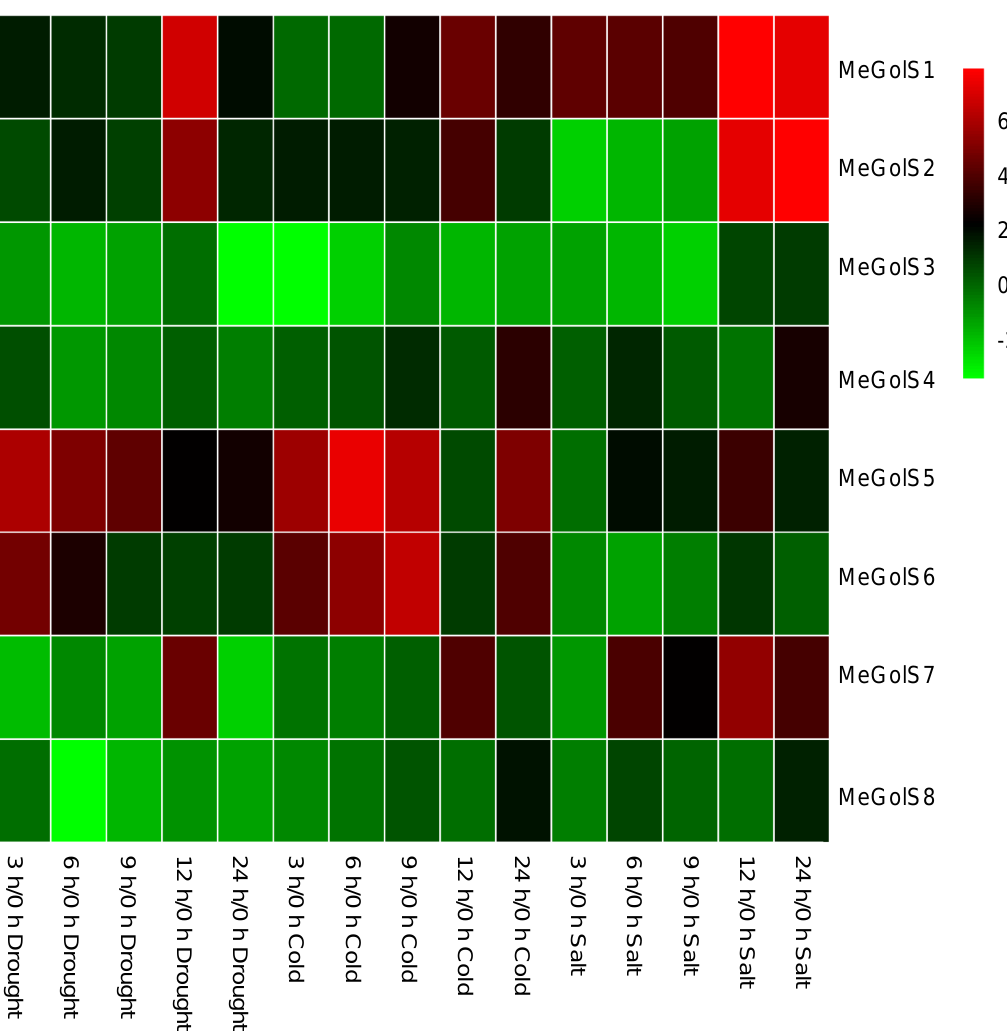
Figure 5. Expression abundance of MeGolSs under drought, cold, and salinity abiotic stresses in cassava. The bars indicated the relative gene expression levels, calculated based on the 2 − △△ Ct method. The expression levels were equal to the mean values and transform log2 values.